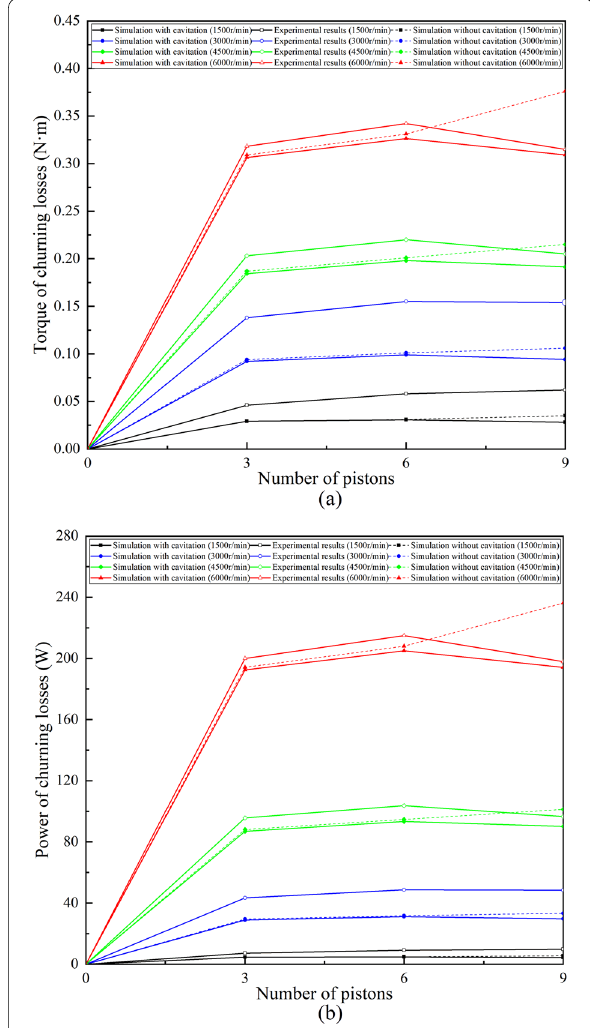
Figure 12 Comparison of experimental results and simulation results: a torque of churning losses, b power of churning losses